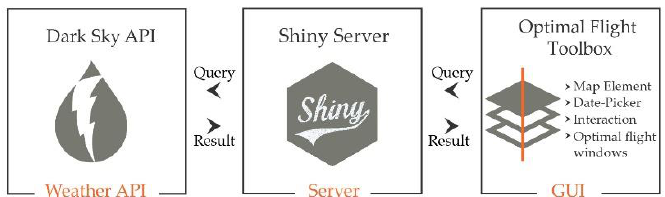
Figure 1. Architecture schema of the application.